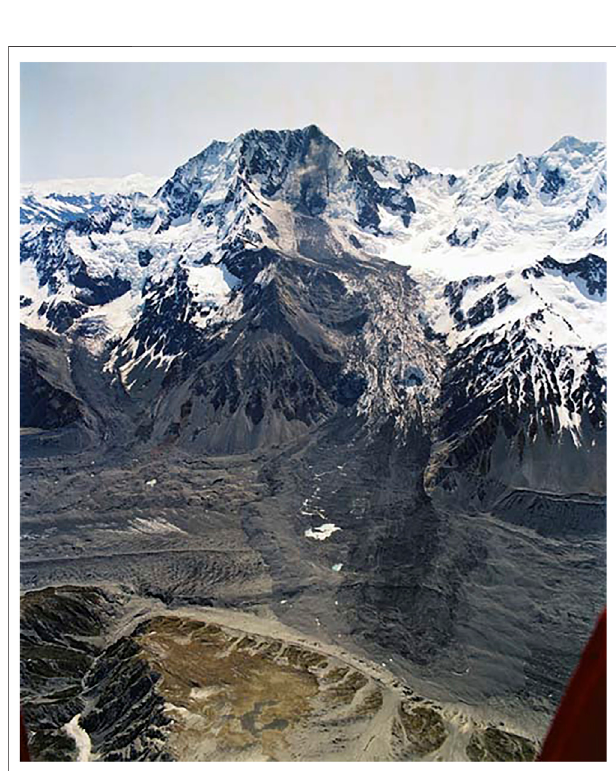
FIGURE 5 | Perspective view of the 1991 Mount Cook landslide (photo by Lloyd Homer, GNS Science).